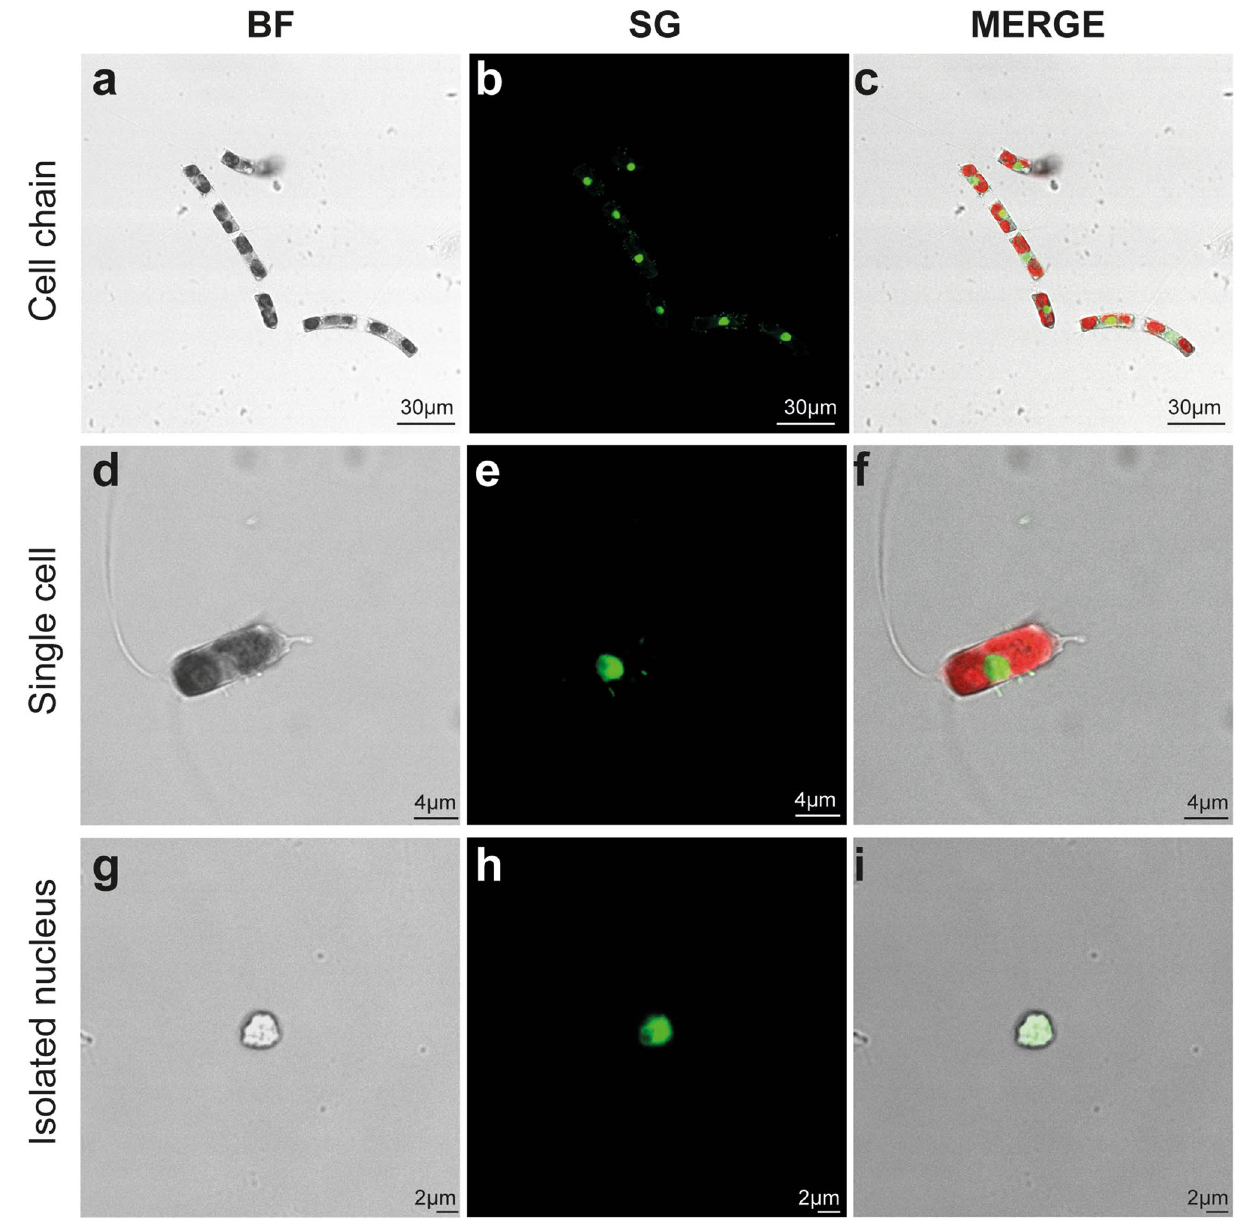
Figure 3. Confocal microscopy analysis of C. diadema cells and isolated nuclei. Bright-field and fluorescence microscopy images of intact cell chains ( a – c ), single cell ( d – f ) and sorted nuclei ( g – i ) for C. diadema . In ( c )